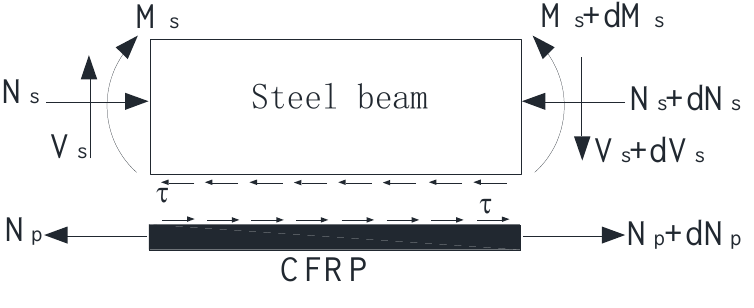
Figure 1. The force graph of unit body.